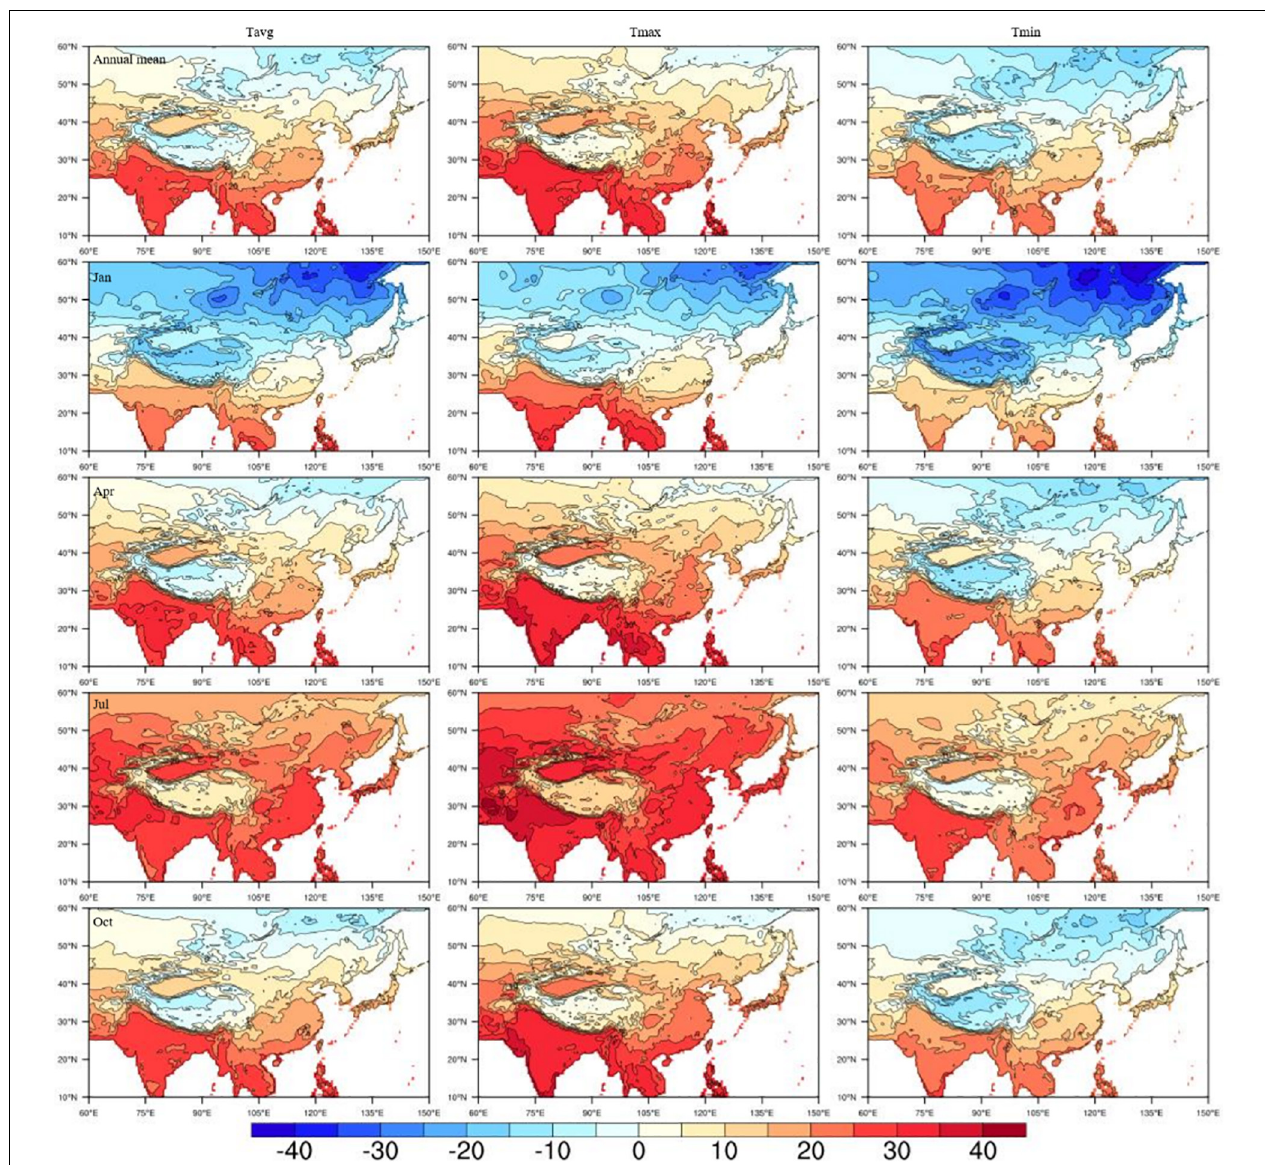
FIGURE 4 | Gridded climatology ( ◦ C) of LSAT over eastern Asia for (top to bottom) annual mean and different seasons (presented by January, April, July, and October) of mean, maximum and minimum temperature (left to right).